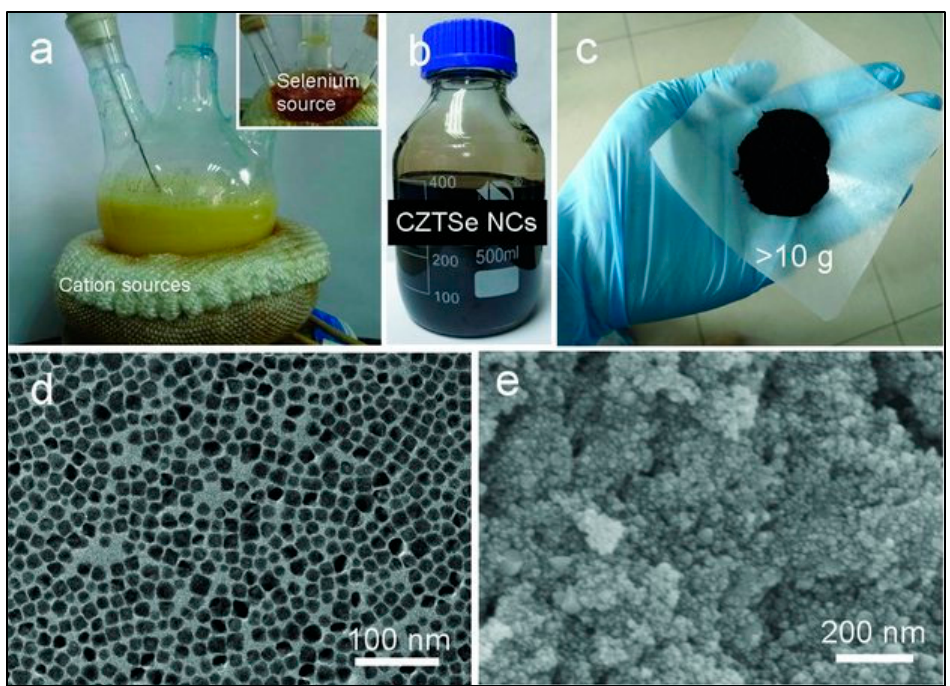
Figure 2. ( a ) Large-scale colloidal synthesis of copper zinc tin selenide (CZTSe) (pictures of the reaction flasks), ( b ) The synthesized non-stoichiometric CZTSe nanocrystals dissolved in hexane, ( c ) More than 10 g synthesized surface-clean CZTS nanoparticles, ( d , e ) Transmission Electron Microscopy (TEM) and Scanning Electron Microscopy (SEM) images of the synthesized nanoparticles. Reproduced with permission from [52]. Copyright Wiley Online Library, 2017.